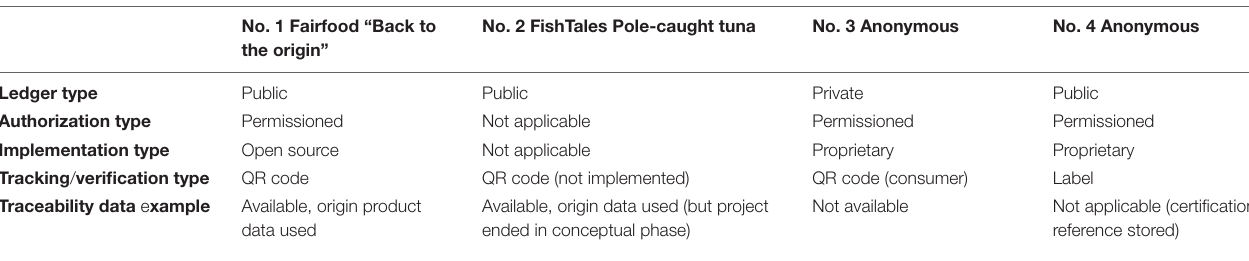
TABLE 6 | Technical case